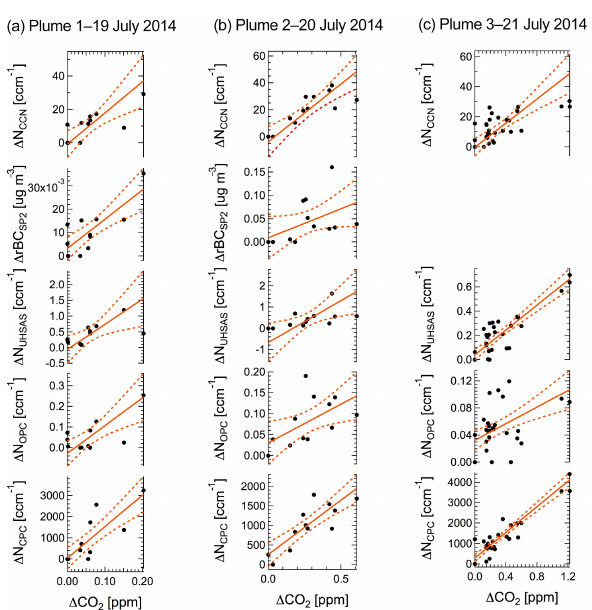
Figure 11. Scatter plot for excess particle concentration vs. excess carbon dioxide for plumes 1 (a) , 2 (b) , and 3 (c) . Measurements are shown by black markers. The linear model fit is shown with a solid red line, and the 90% confidence band for the linear model fit is shown with dashed red